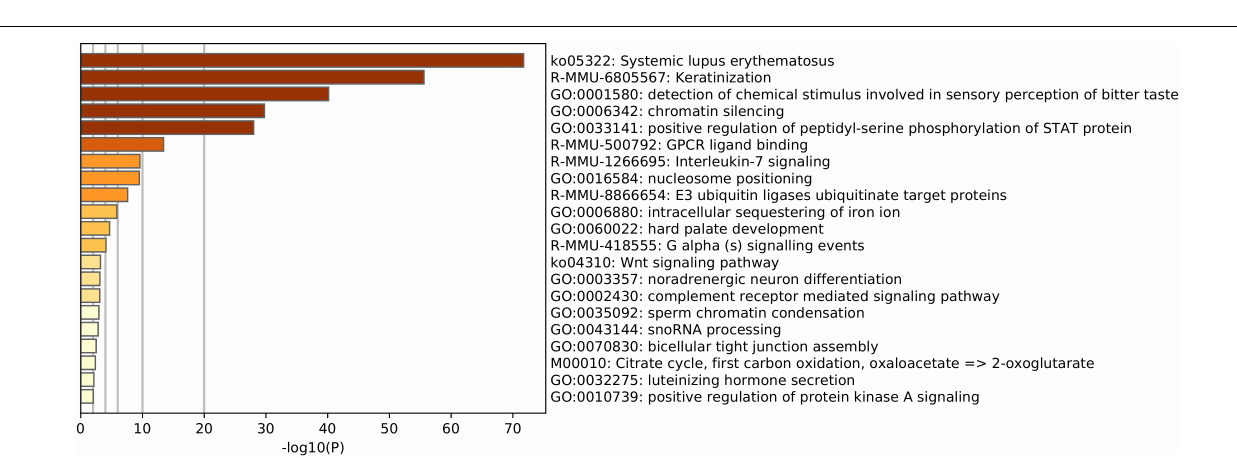
Bhlhe23, Pou3f1, Pou3f2, Pou3f4, Foxq1, and Neurog1 , most